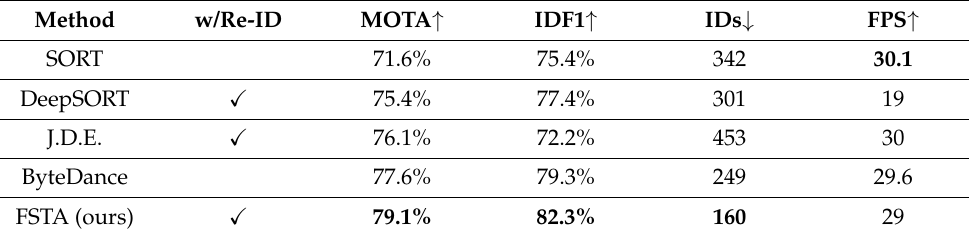
Table 4. Comparison of different data association methods on the validation set. The best results are shown in